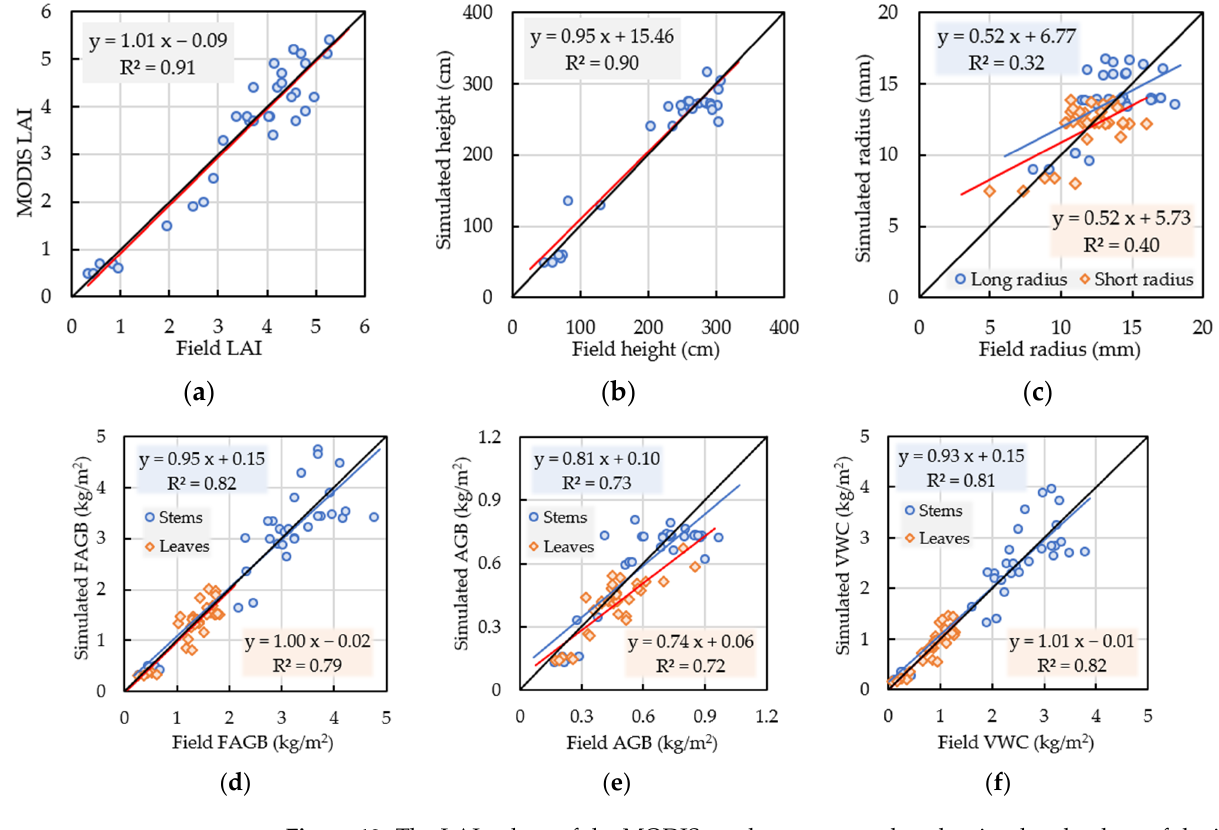
Figure 10. The LAI values of the MODIS product were used as the simulated values of the input parameter to compare the results of the field measurements of the canopy parameters in six areas, ( a ) LAI, ( b ) maize height, ( c ) radius, blue circles and orange diamonds representing long and short radius, respectively, ( d ) FAGB, ( e ) AGB, and ( f ) VWC, blue circles and orange diamonds represent the stem and leaf of the maize components, respectively. Table 6. The accuracy results of the simulated maize canopy parameters were compared to the field- measured datasets separately, based on two methods of dividing the entire growing season into two stages using the MODIS-product LAI values and the field-observed values of the extreme value points.